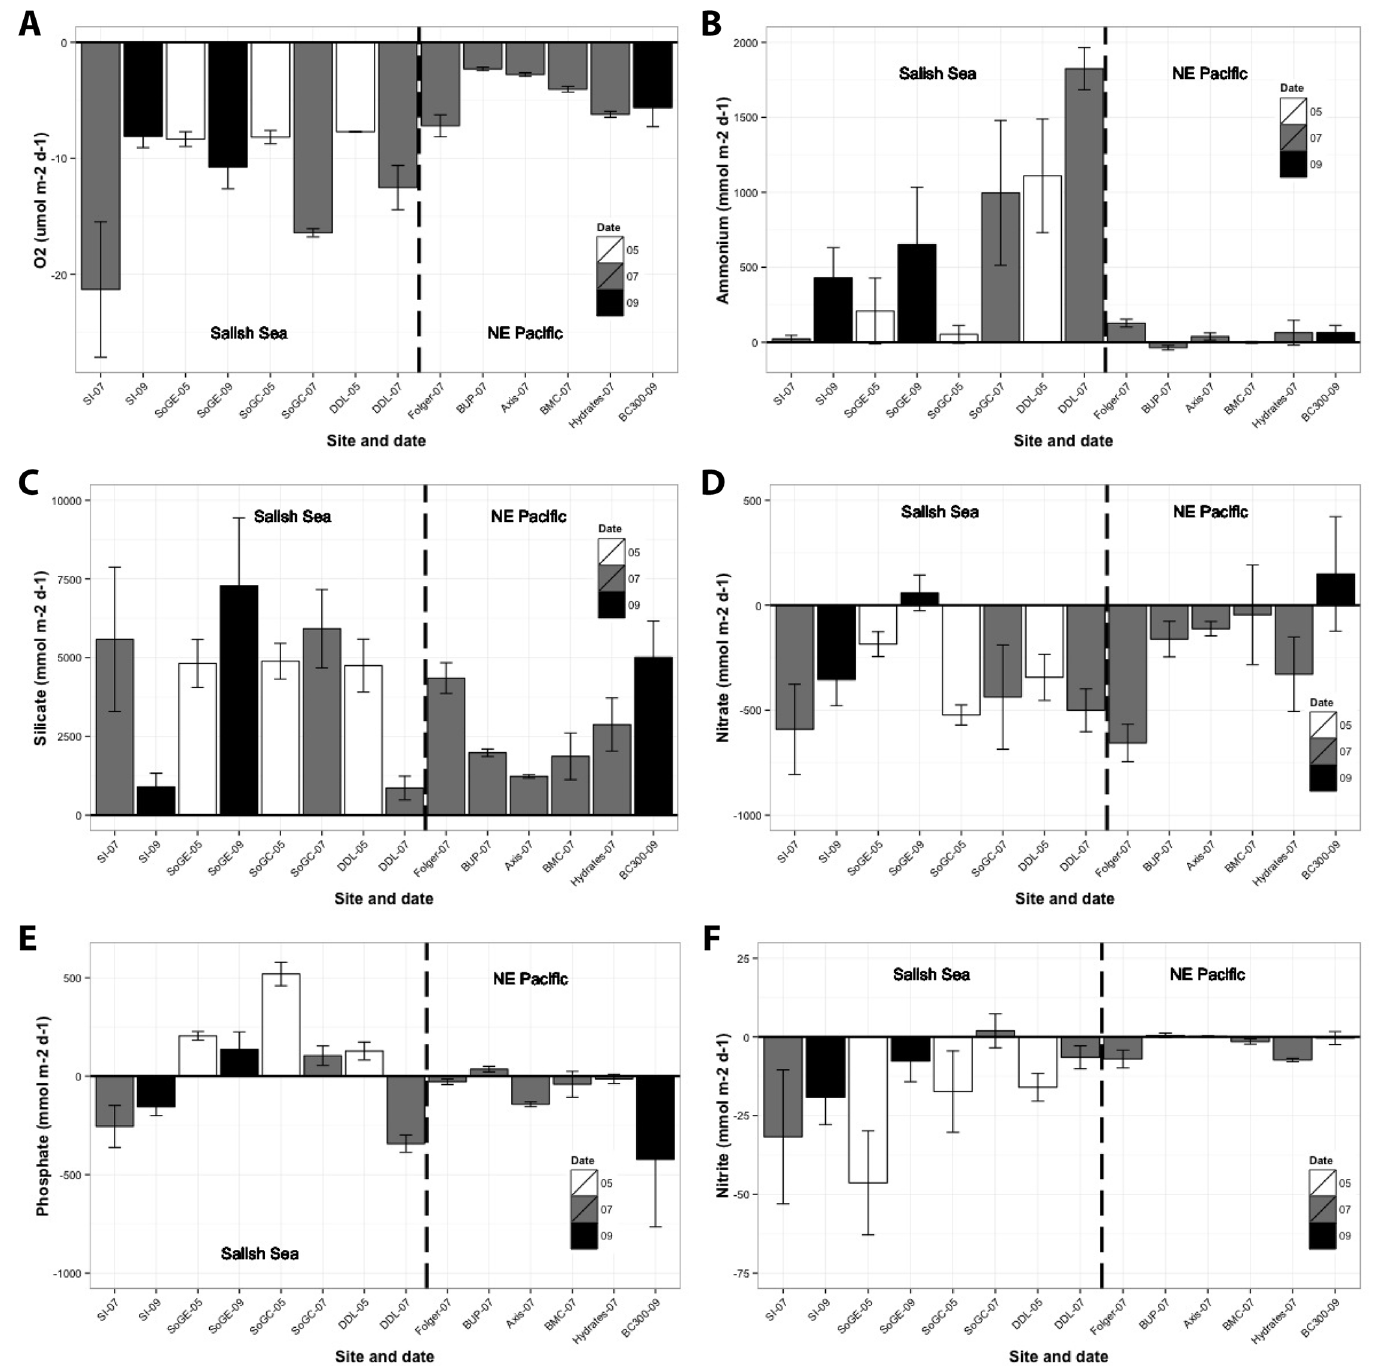
Fig 2. Benthic fluxes ( ± SE) of a) oxygen, b) ammonium, c) silicate, d) nitrate, e) phosphate and f) nitrite measured at each location. Oxygen uptake is reported in mmol m -2 d -1 whereas other fluxes units are reported in μ mol m -2 d -1 . White bars represent fluxes measured in May 2011, grey bars represent fluxes measured in July 2011, and black bars represent fluxes measured in September 2013. Horizontal lines indicate sediment – water interface where fluxes above the lines represent sediment release and fluxes below the lines represent sediment uptake. Vertical dashed lines separate Salish Sea (left) and NE Pacific (right)